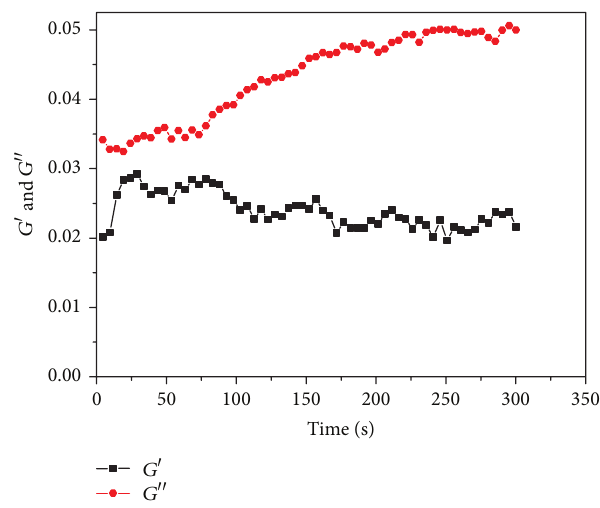
Figure 6: Variation in time of G 󸀠 and G 󸀠󸀠 for a representative sample of ureasil-PPO or ureasil-PEO, produced with NH 4 F as catalyst agent.